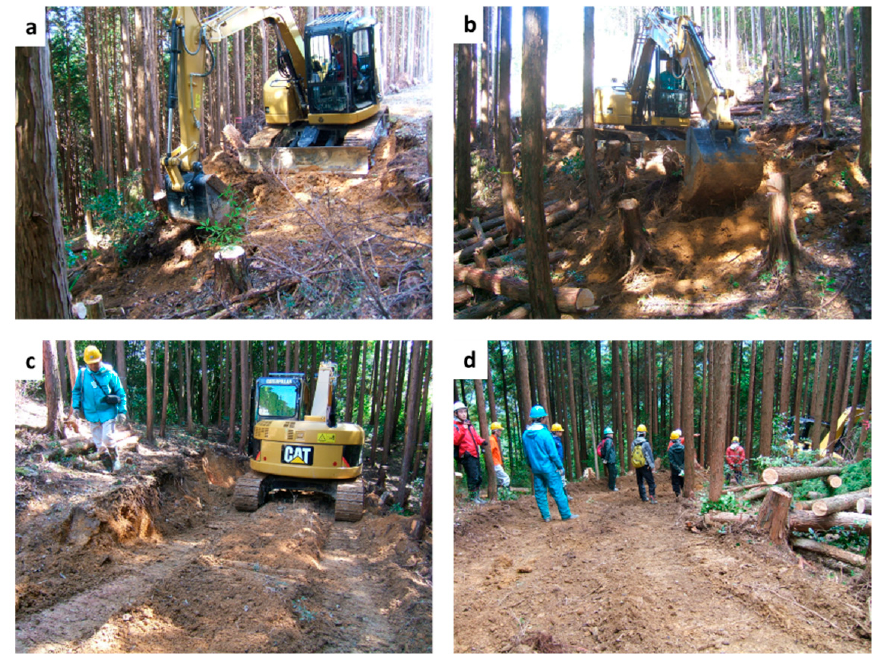
crease the embankment volume. The cut slope can be constructed as vertical if its maximum height is less than the limit height of 1.4 m.